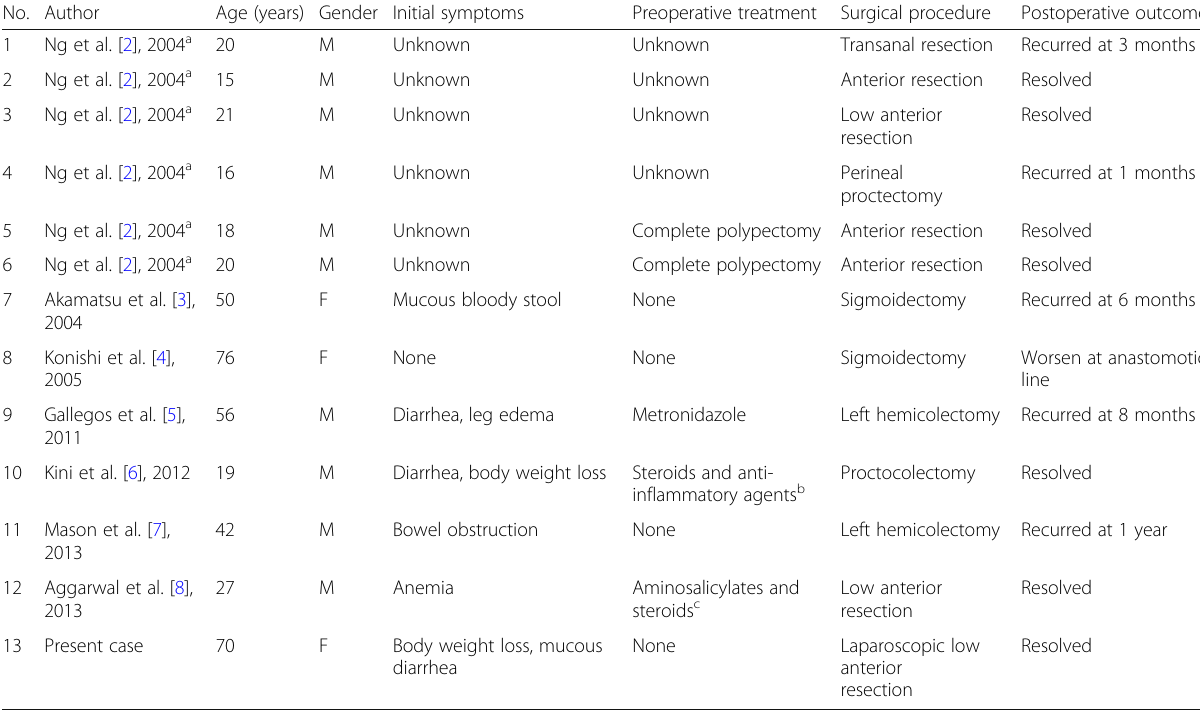
Table 1 Cases of cap polyposis treated by surgery from the previously published English literature No.